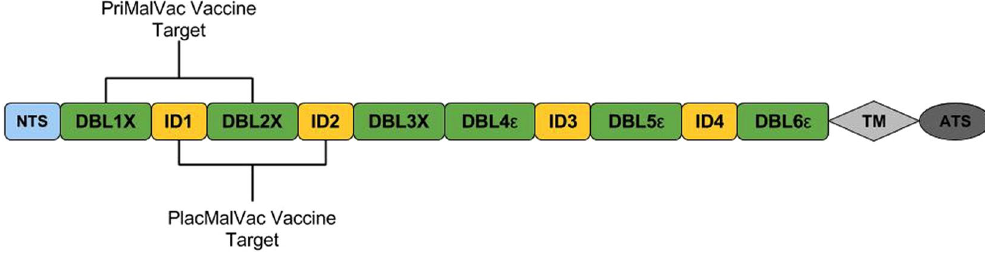
Figure 1. Schematic representation of the var2csa gene. VAR2CSA consists of an N-terminal segment (NTS), six Duffy Binding Like Domains (DBL), four cysteine-rich interdomain regions (ID), a transmembrane domain (TM), and an intra-cellular acidic terminal segment (ATS). Current vaccine development efforts (PlacMalVac and PriMalVac) are targeting the NTS-DBL2x region. The ID1-DBL2x region has recently been identified as the minimal CSA-binding region that contains major protective epitopes and elicits a strong host immune response 15, 21–29